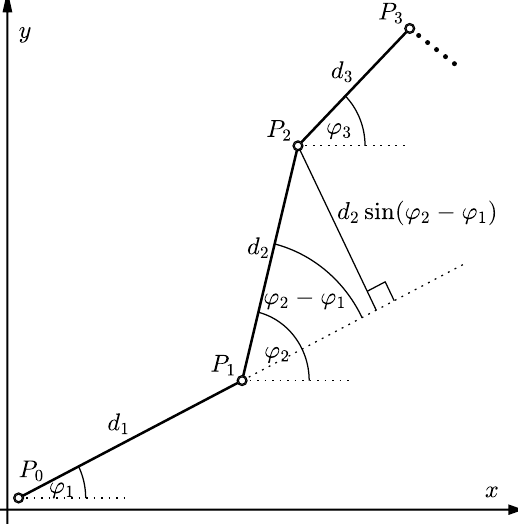
Figure 1. Geometric relations among the control points of a Bézier curve: d i represents the length of −−−→ P i P i + 1 while ϕ i is its angle with respect to the positive direction of the x the vector